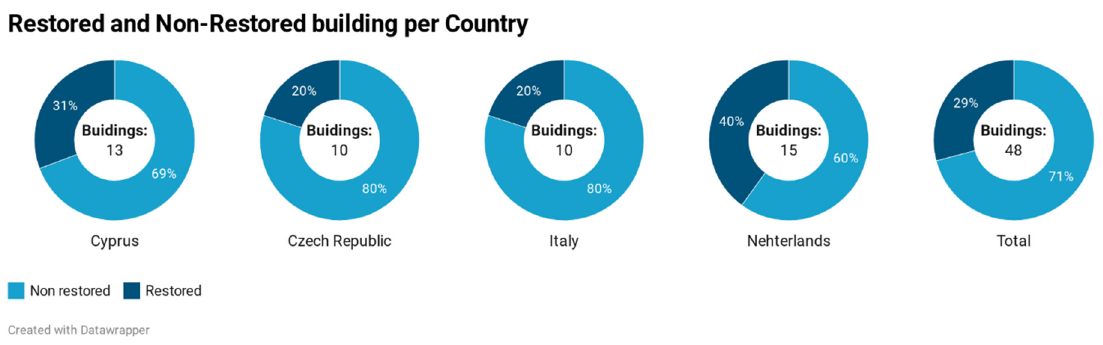
Figure 9. Restored and non-restored buildings per country.